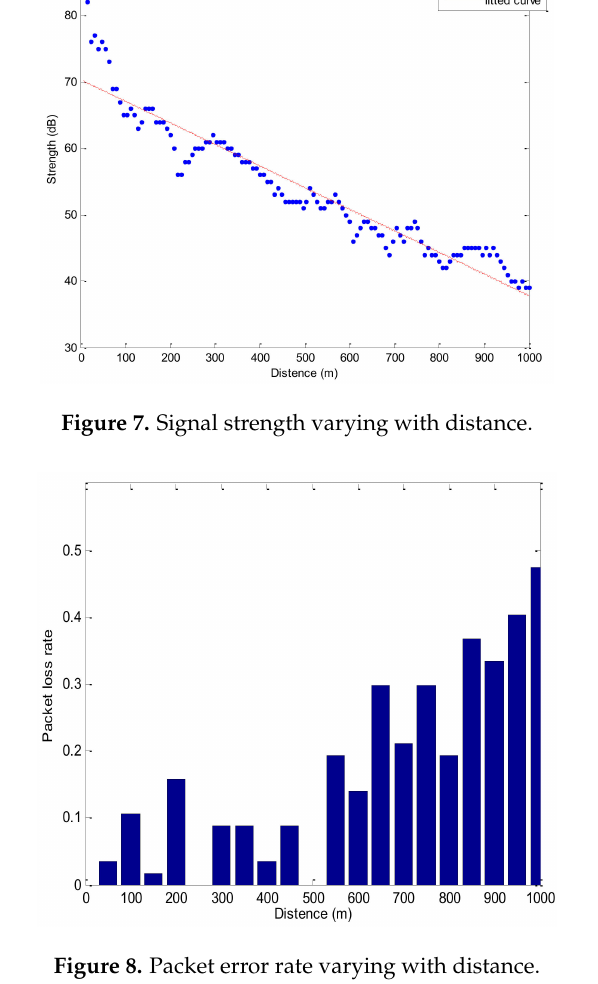
Figure 8. Packet error rate varying with